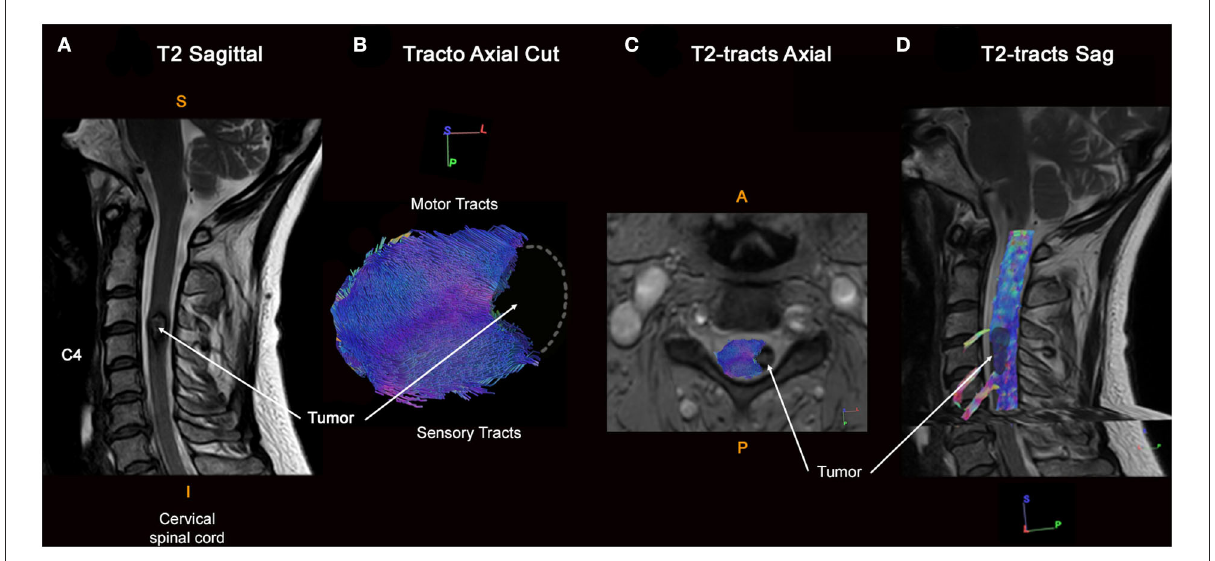
FIGURE4 Full cervical cord tractography in a patient with intramedullary cavernous malformation. (A) Sagittal T2-weighed images showing the cavernous malformation at the C3–C4 spine level. Cavernous malformation presented an exophytic portion on the left side of the spinal cord, with a hemosiderin crown in a hyposignal T2-weighted sequence. (B) Axial view of spinal cord tractography at the C3–C4 level shows that spinal fibers were pushed back and compressed by the cavernous malformation, without fibers around the cavernous malformation (at its dorso-lateral part). Left lateral view of cervical spinal cord tractography showing a notch within the spinal cord repressing spinal tracts. (C) Overlay of the spinal cord tractography on the axial T2-weighted MR images. (D) Overlay of the spinal cord tractography on the sagittal T2-weighted MR images, with the 3D rendering of the cavernous malformation (in black).